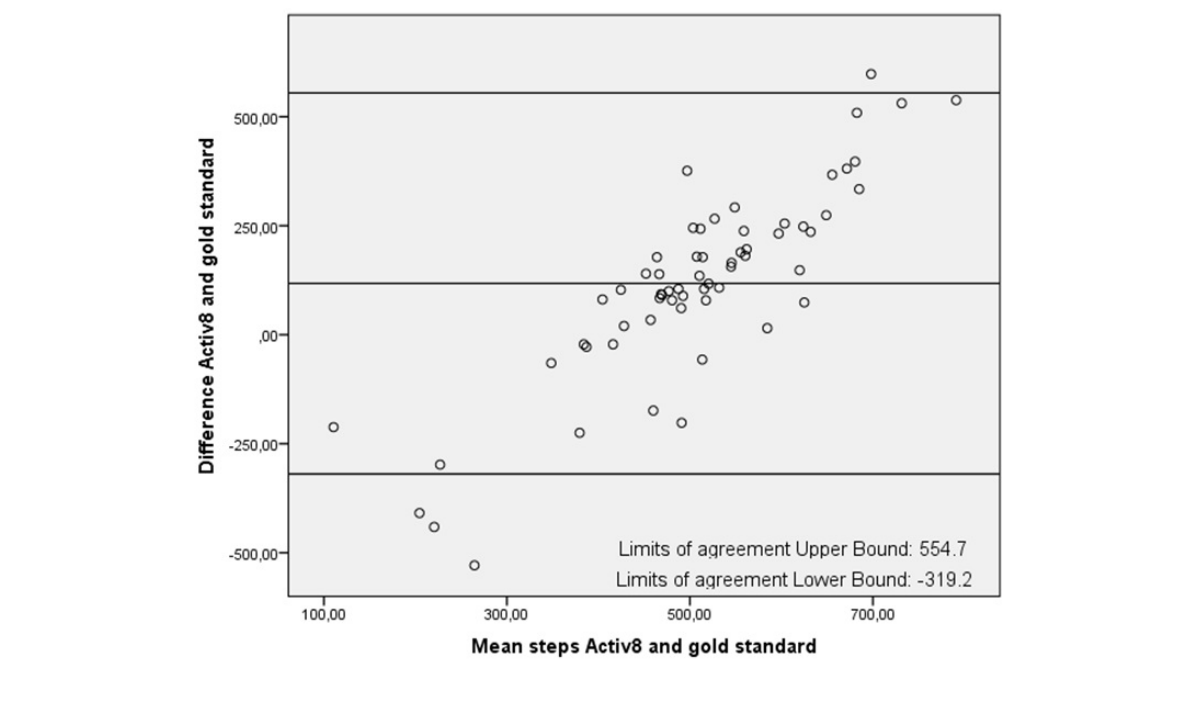
Figure 5. Bland-Altman plot of the Aciv8 and the gold standard.